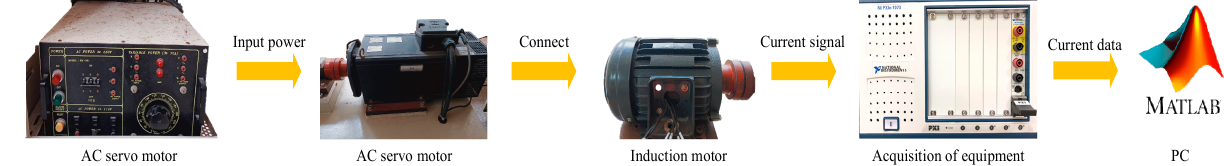
Figure 7. Signal measurement process.